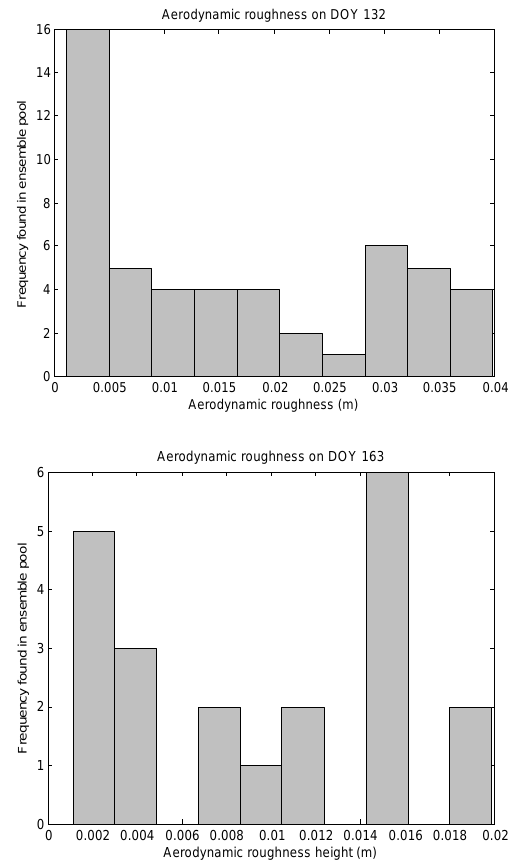
Fig. 4. Frequency of aerodynamic roughness on different days.